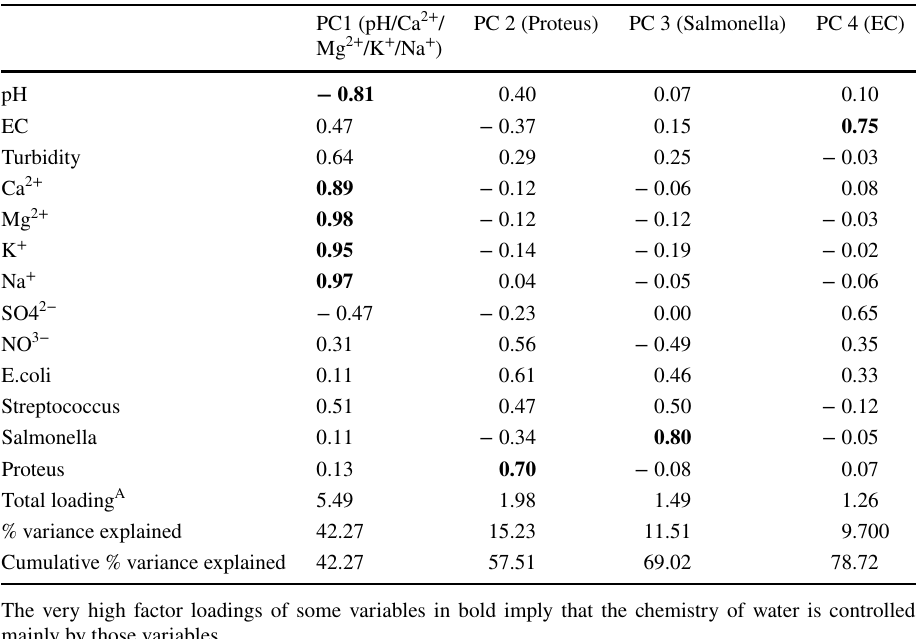
Fig. 3 Seasonal variations of major cations (mg/l) in the Mezam River